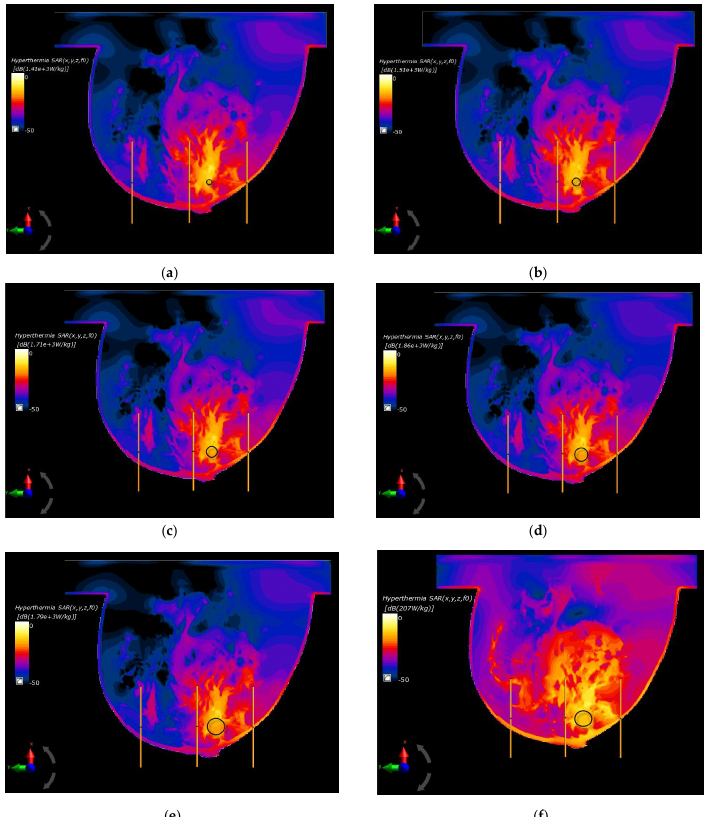
Figure 6. Normalized specific absorption rate (SAR) distributions in the xy plane from an eight-dipole antenna array after the optimization procedure (sum P i = 8W) for various tumor radii: ( a ) r = 4 mm; ( b ) r = 6 mm; ( c ) r = 8 mm; ( d ) r = 10 mm; ( e ) r = 12 mm; ( f ) r = 12 mm—before the optimization procedure ( ϕ i = 0 and P i = 1 W).